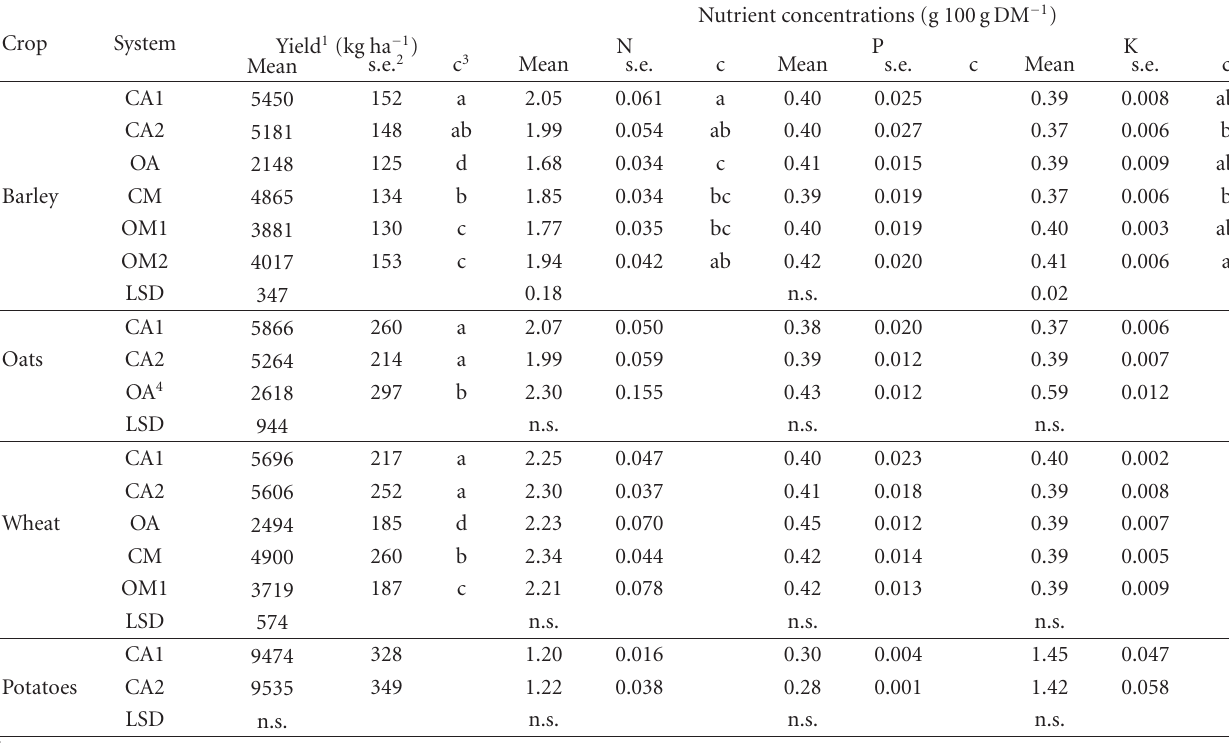
Table 3: Harvested yields of cereals and potatoes and their concentrations of N, P, and K.